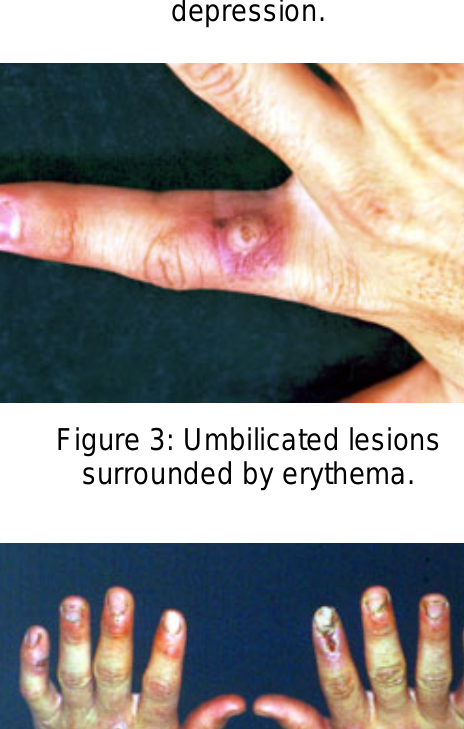
Figure 2: Ulcerated nodule with small crusts in its surface.